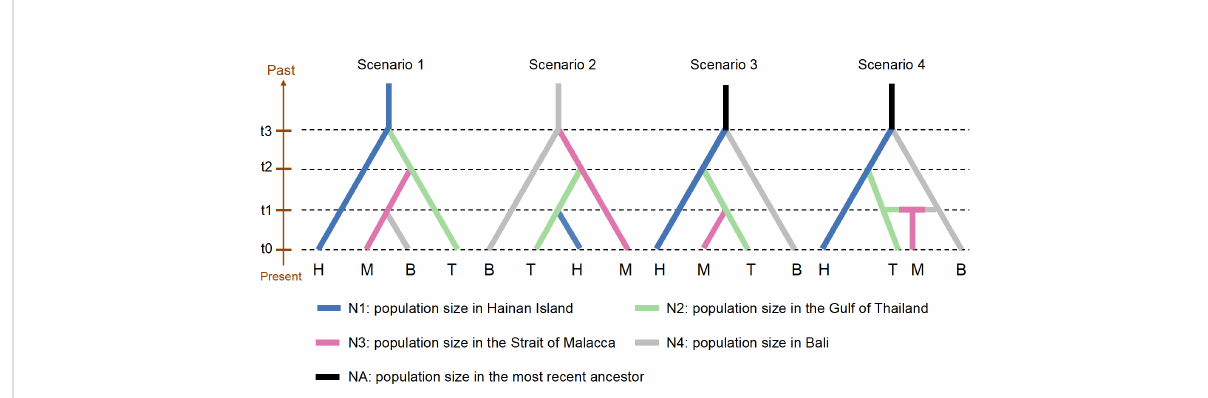
FIGURE 4 Probable demographic scenarios tested with approximate Bayesian computation (ABC) models implemented in DIYABC. Prior distribution parameters are listed in Supplementary Table